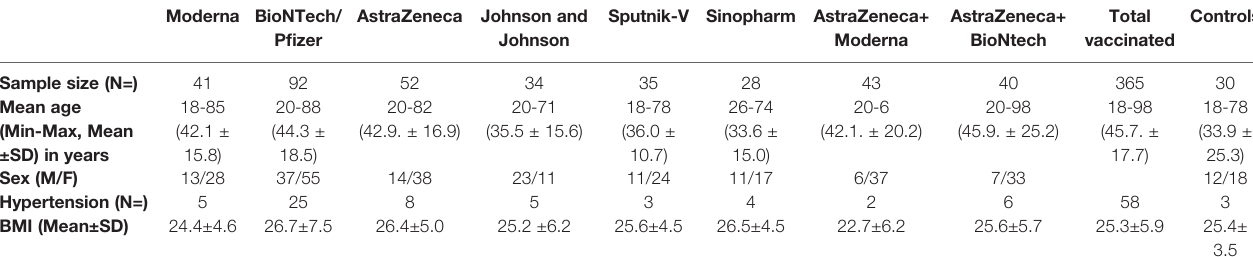
TABLE 1 | Epidemiological and clinical characteristics of study